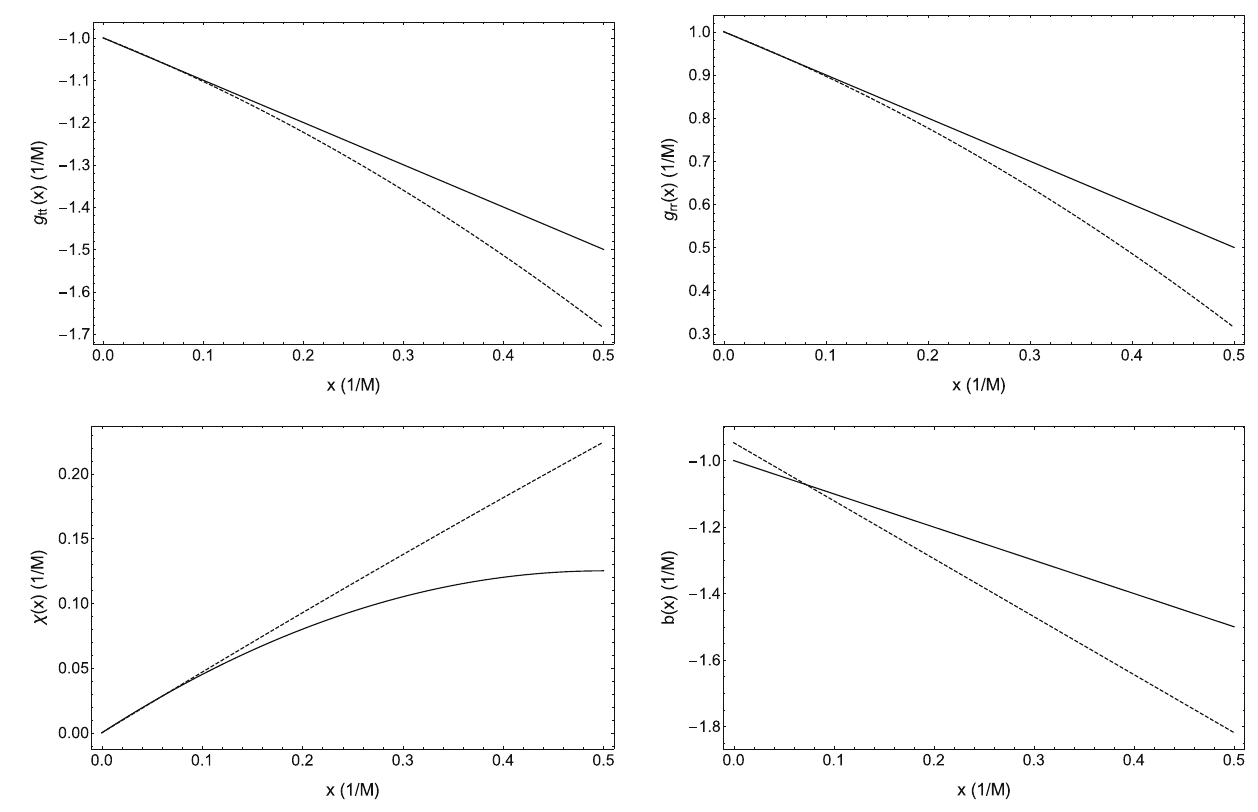
Fig. 2 WH metric time g tt ( x ) and radial g rr ( x ) components, and red- shift χ( x ) and shape b ( x ) functions plotted in terms of the inverse of the radial distance x for f ( R ) (continuous lines) and R + α 0 R 2 + α 1 R (cid:2) R (dashed lines) theories. The WH solution has been reconstructed by considering the globular cluster NGC 4649 , having an effective radius